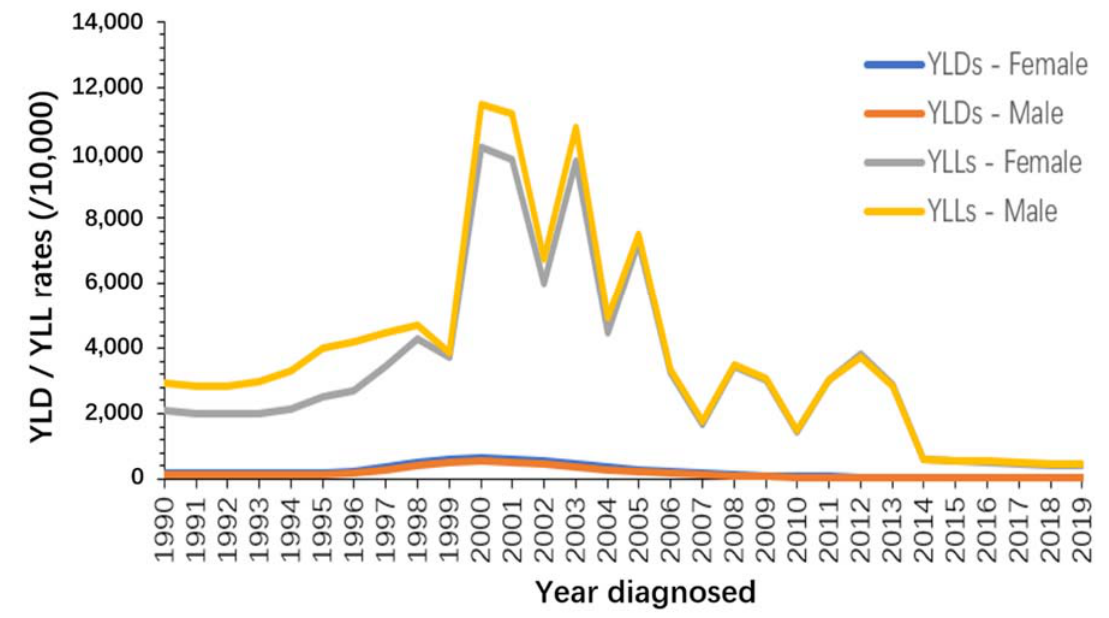
Figure 8. The trend of YLD rate and YLL rate of malaria, STP, 1990–2019.